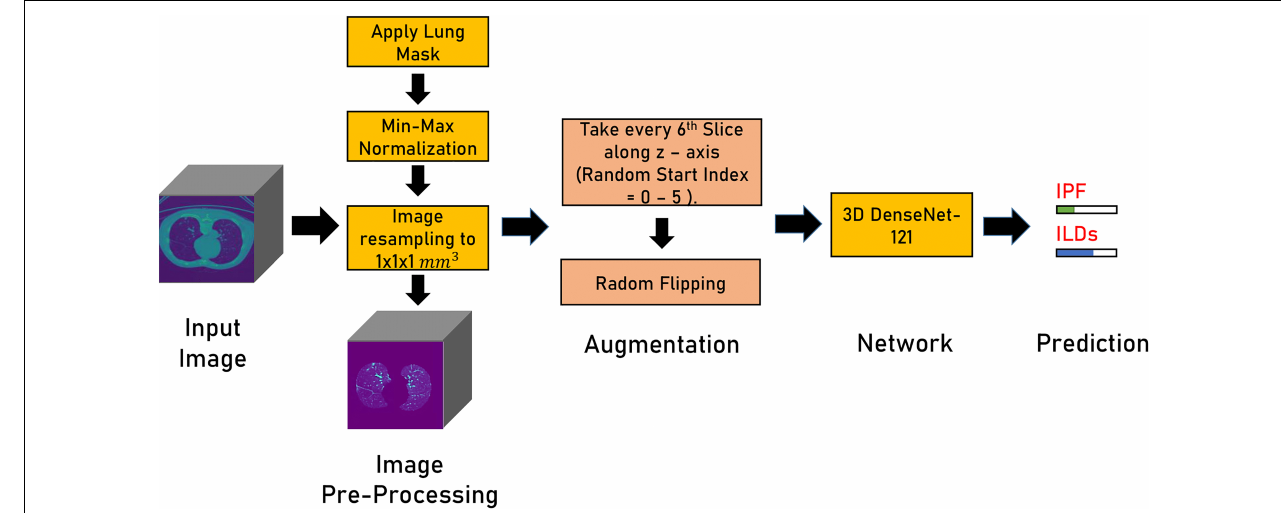
TABLE 1 | Demographic and clinical information of the study participants.